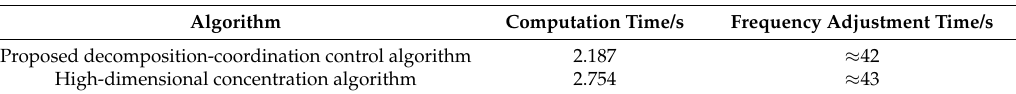
Table 3. Computation time and frequency adjustment time comparisons at each time-step.